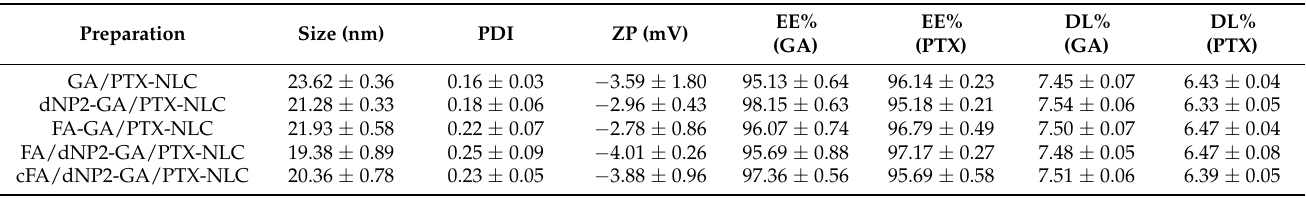
Table 1. Particle size, polydispersity index (PDI), zeta potential (ZP), encapsulation efficacy (EE), and drug-loading capacity (DL) of GA/PTX-NLC and targeted GA/PTX-NLC (mean ± SD, n =